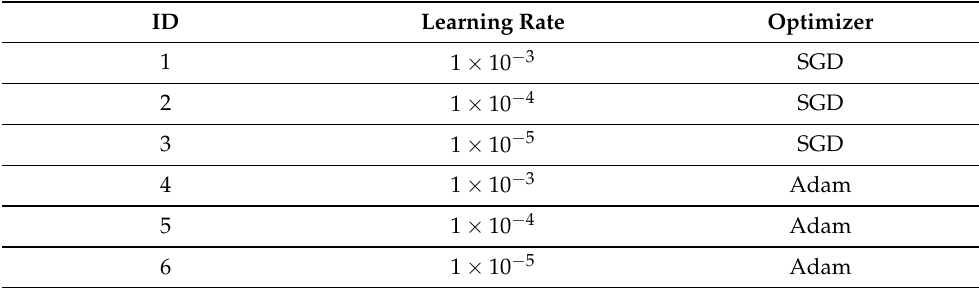
Table 2. Exploitation grid